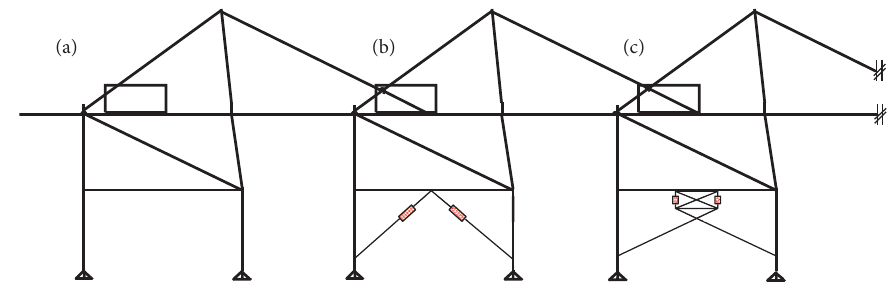
Figure 10: Analysis models: (a) Model BS, (b) Model DB, and (c) Model SS.